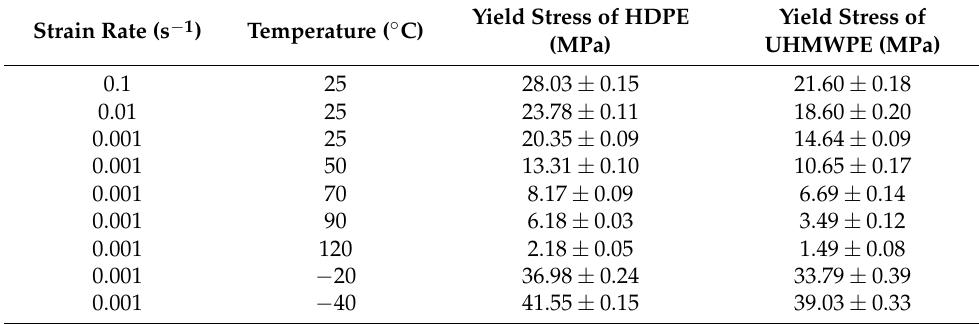
Table 3. Compressive properties of HDPE and